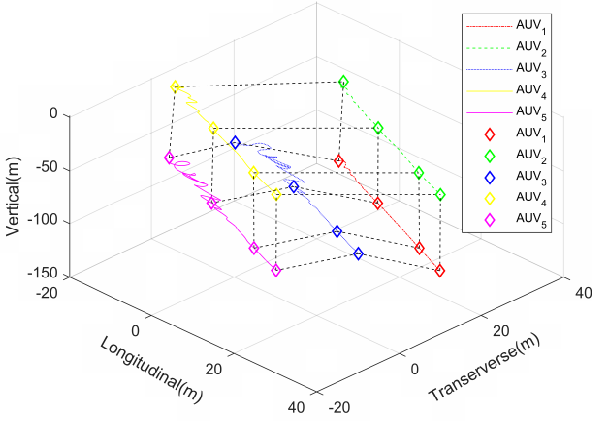
Figure 13. The 3D trajectory of the multi − AUV